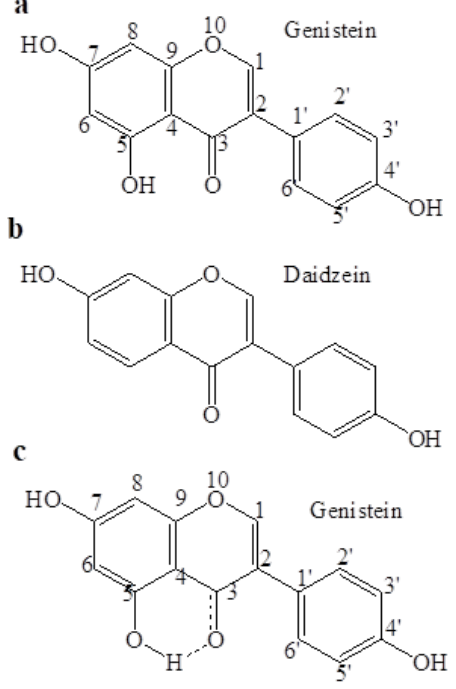
Figure 6. Chemical structures of ( a ) genistein, ( b ) daidzein, and ( c ) a possible chemical bond between the hydrogen atom at C 5 and carbonyl group at C 3 of genistein .